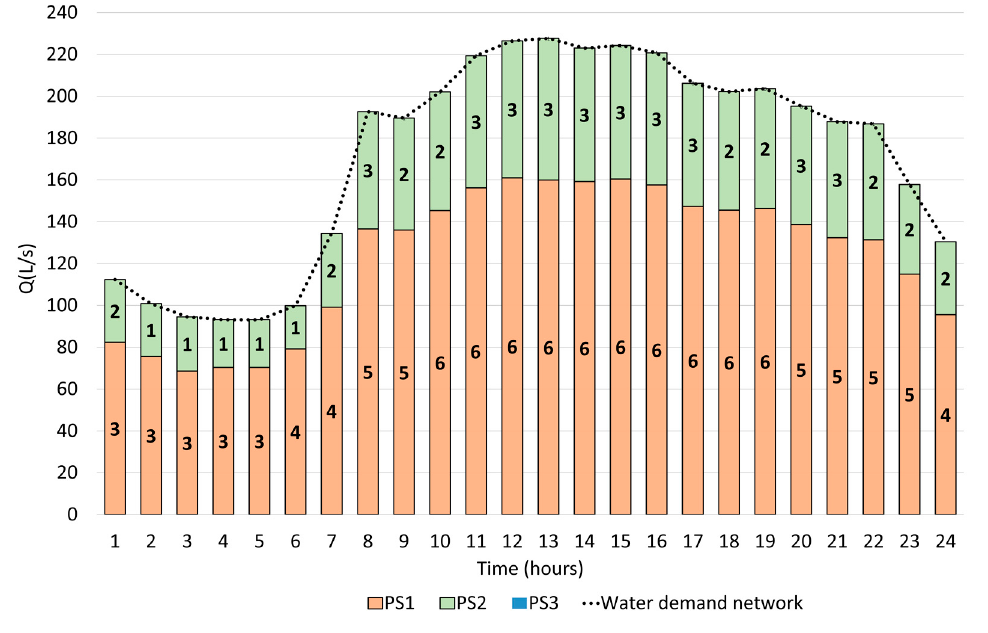
Figure 9. Best solution using IMs.